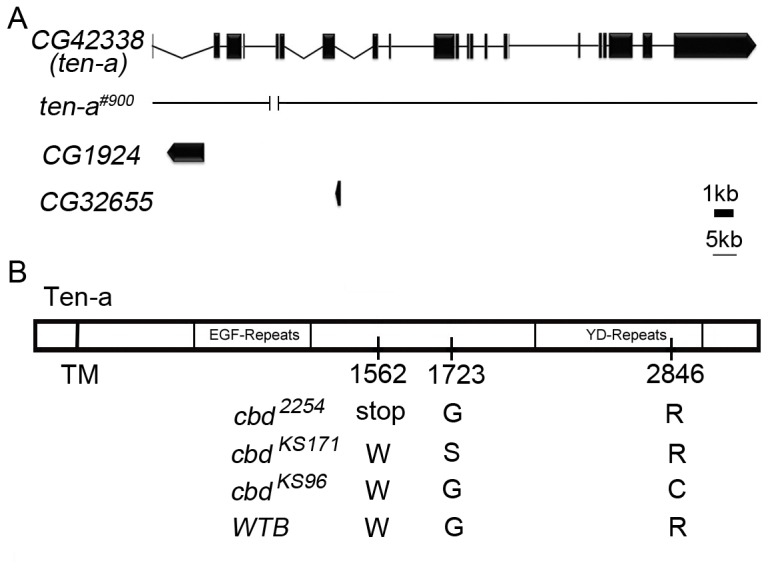
Schematic drawing of genomic region containing ten-a.(A) Schematic drawing of CG42338 (ten-a), CG1924, CG32655, and ten-a deficiency line ten-a#900. (B) Schematic drawing of mutant site of Ten-a. In cbd 2254, Tryptophan at 1562 is changed to a premature stop codon. In cbd KS171, Glycine at 1723 is changed to Serine. In cbd KS96, Arginine at 2846 is changed to Cysteine.